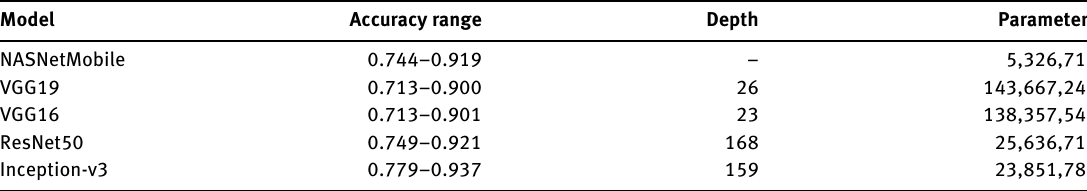
Table 3: Comparison of Various Pre-trained Deep